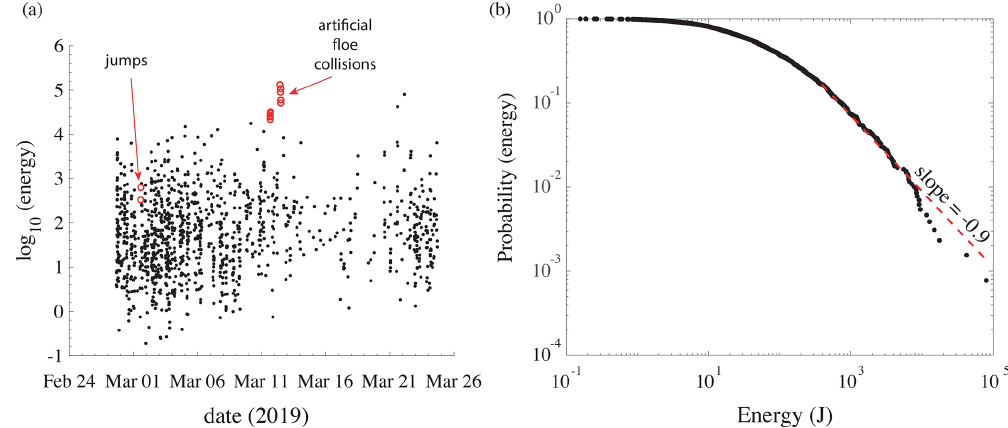
Figure 9. (a) Energy versus date of all inverted icequakes (black dots) and artificial sources (red circles). (b) Scaling law of the icequake